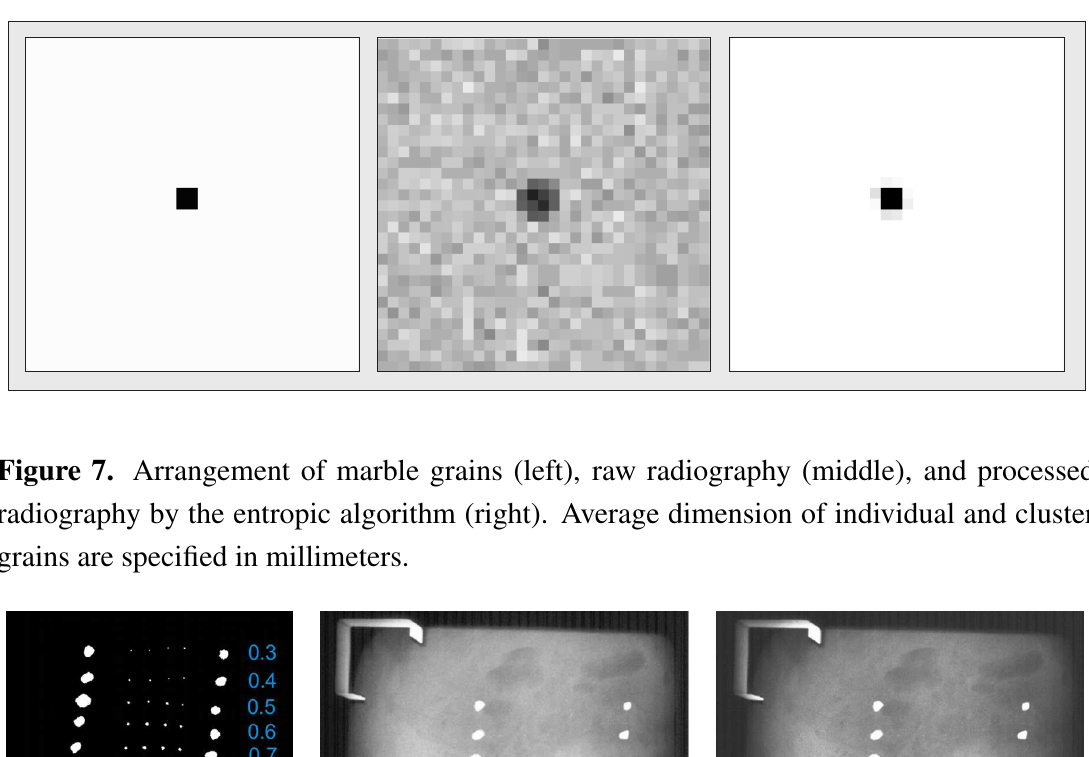
Figure 6. Artificial-generated opacity of 2 × 2 pixel size (left) embedded in a simulated background breast-like tissue of 31 × 31 pixel area (middle) and subsequently restored by the entropic restoration algorithm.